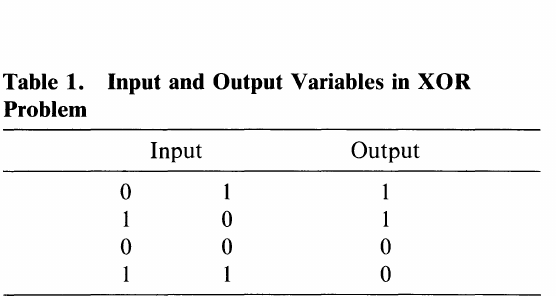
Table 1. Input and Output Variables in XOR Problem